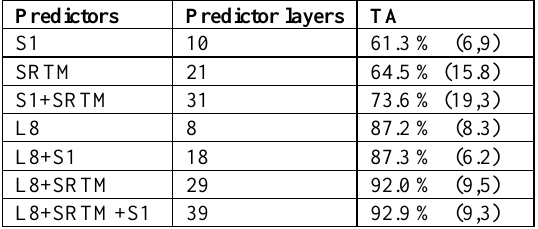
Table 4. Training accuracies with various inputs